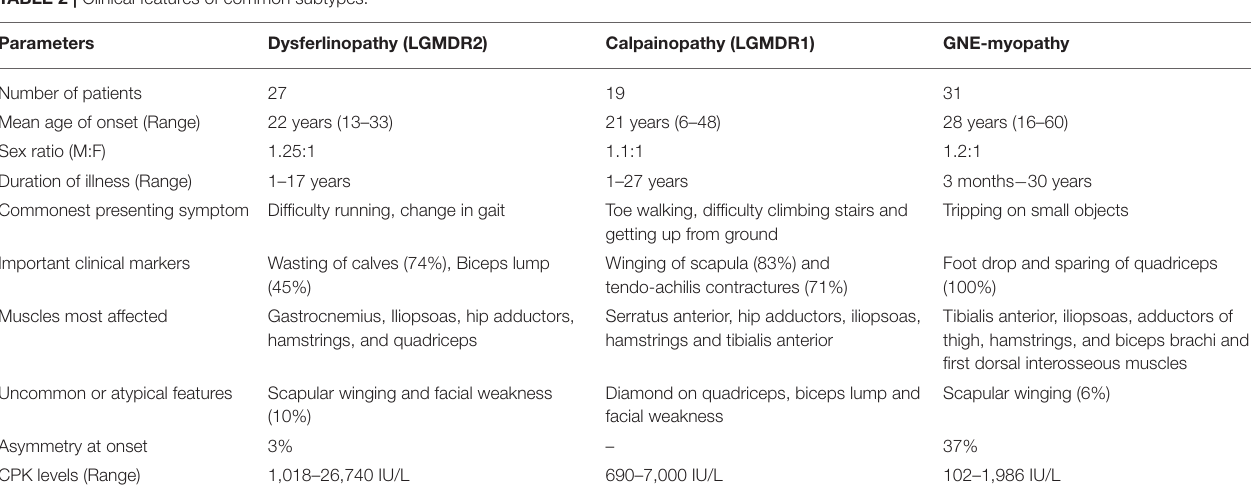
TABLE 2 | Clinical features of common